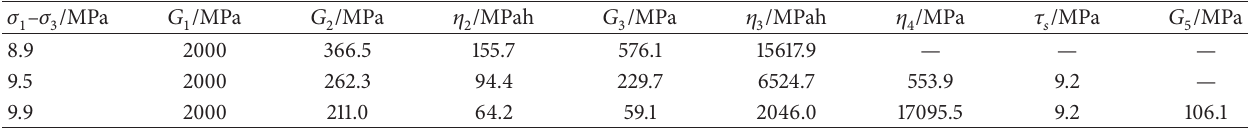
Table 2: Parameters of nonlinear shear creep model for frozen